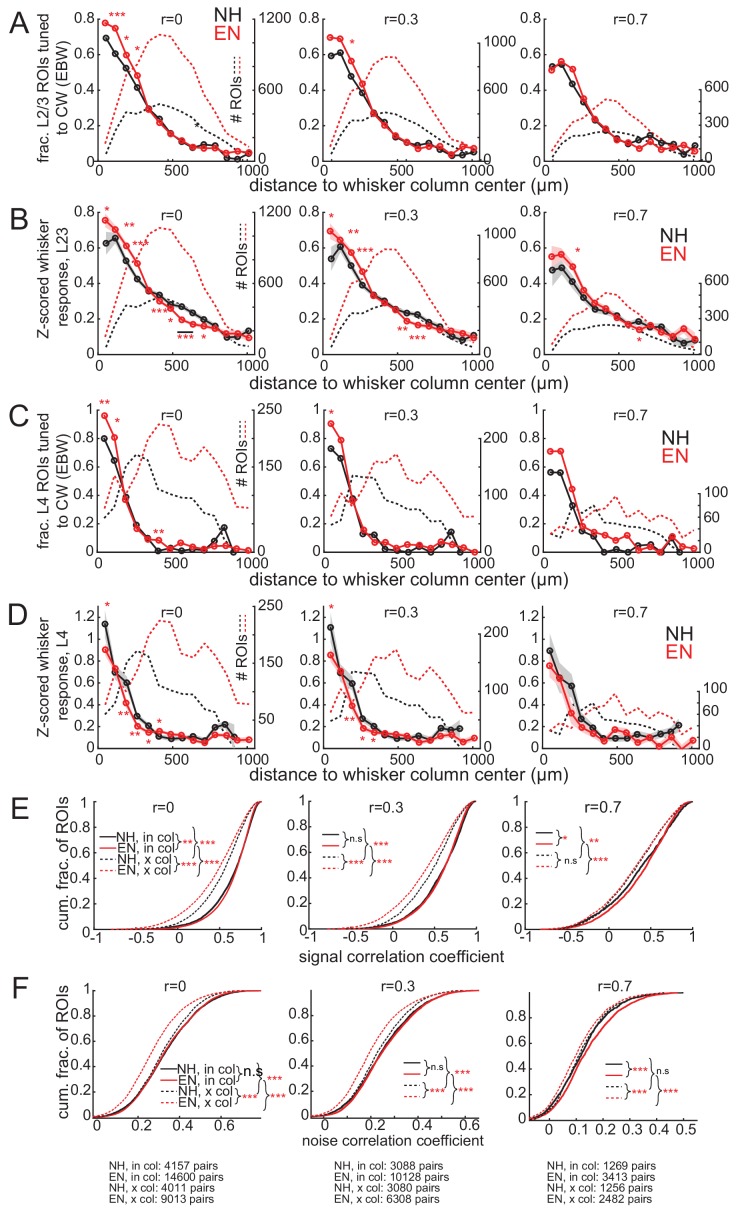
Neuropil subtraction minimally impacts the major effects of the study.(A–F) The principal effects of EN recalculated under different levels of neuropil subtraction. Neuropil subtraction was performed by calculating the raw fluorescence of each ROI on each frame F(t)ROI as F(t)ROI=F(t)ROImask-r*F(t)NPmask. Left column, r = 0 (no neuropil subtraction). Middle column, r = 0.3. Right, r = 0.7. (A) Fraction of L2/3 PYR ROIs tuned to a reference whisker, calculated as in Figure 3A. Asterisks show significant differences between EN and NH by Fisher’ Exact Test, computed separately in each spatial bin. *p<0.05, **p<0.01, ***p<0.001. (B) Mean response evoked by a reference whisker, calculated and plotted as in Figure 2A. (C) Same as in (A), but for L4 excitatory cells. (D) Same as in in (B), for L4 excitatory cells. (E–F) Distribution of signal correlation (E) or noise correlation (F) for all within-column (in-col) and across-column (x-col) L2/3 PYR pairs. Plotted as in Figure 5D and E. Asterisks denote difference between distributions computed by ANOVA with multiple comparisons correction. The bottom row in (F) reports numbers of pairs of significantly whisker-responsive ROIs at each neuropil subtraction weight.